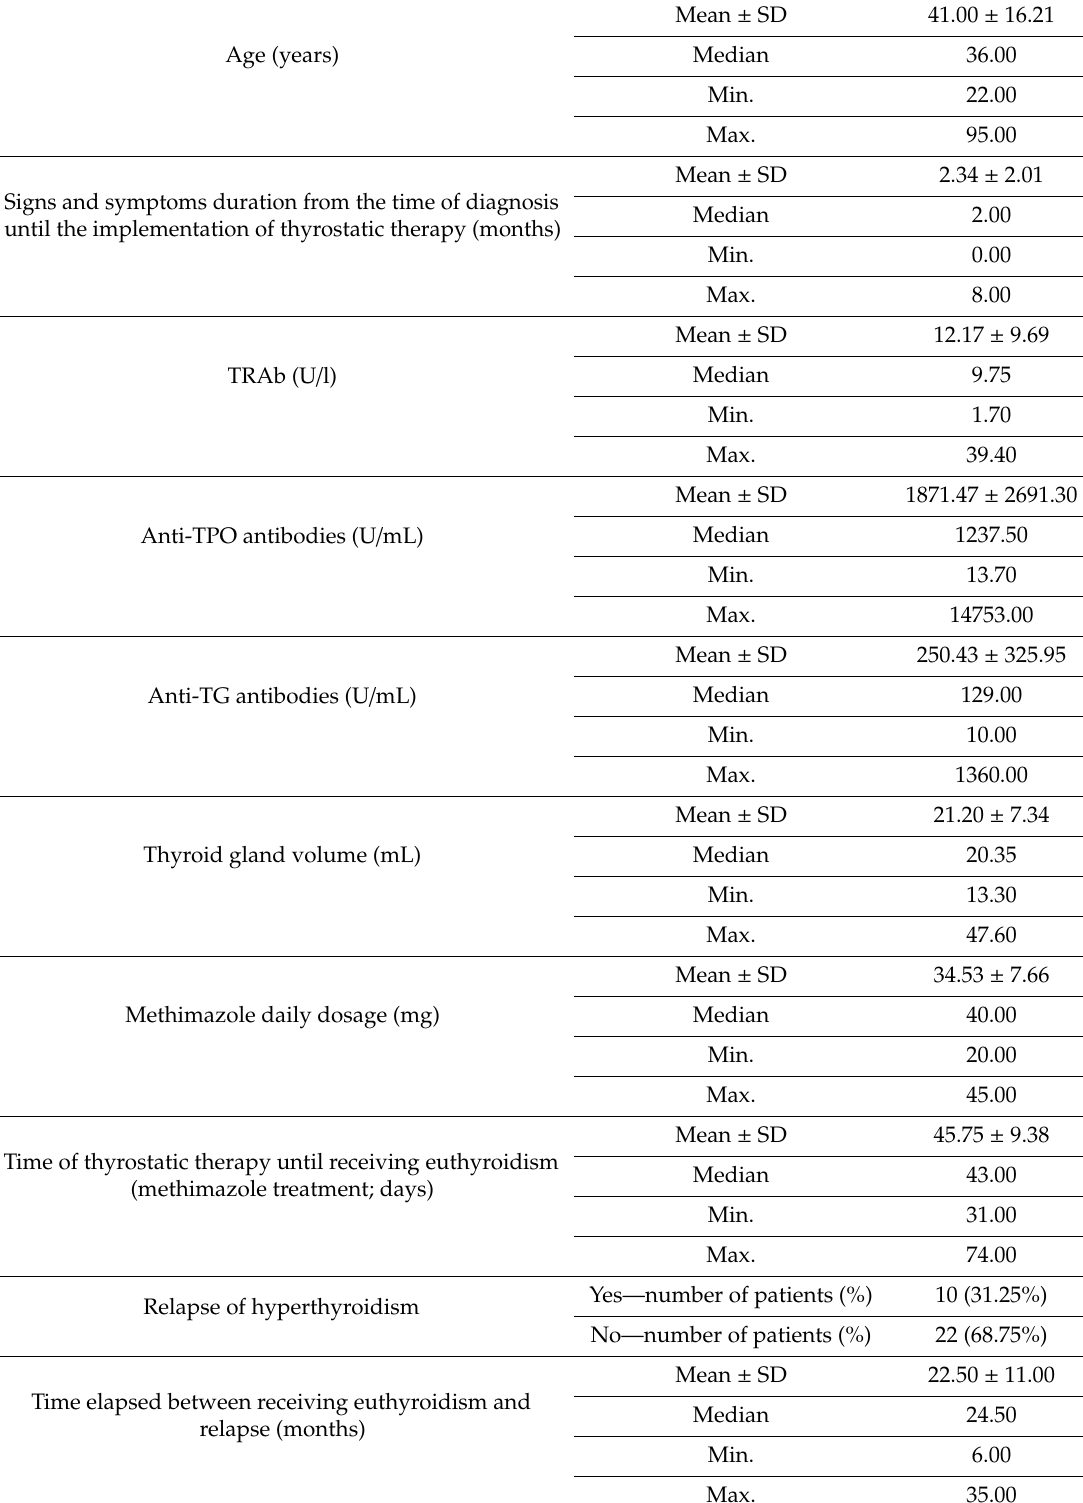
Table 1. Characteristics of the study group ( n =